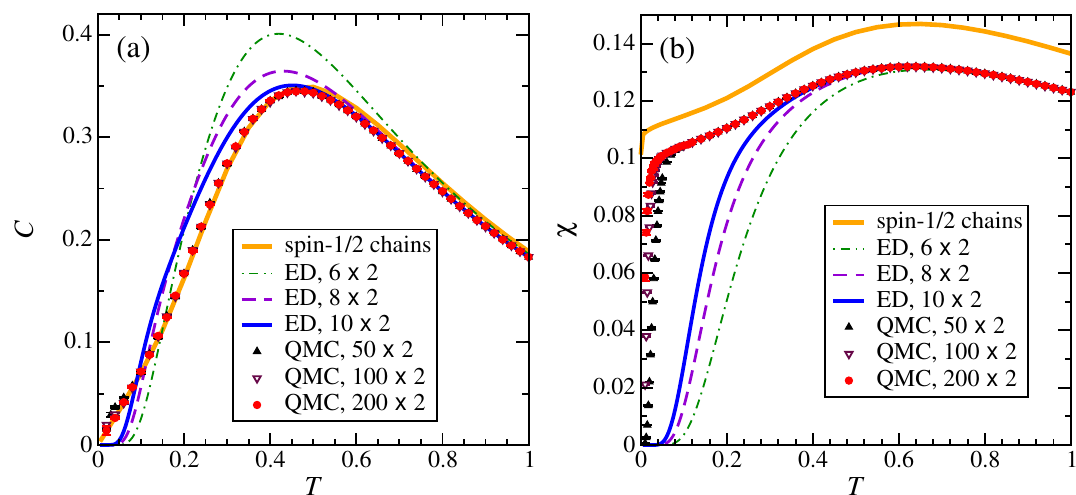
Figure 12: Magnetic specific heat, C , and susceptibility, χ , shown per spin for a ladder with rung coupling J ⊥ = 0.38, leg coupling J (cid:107) = 1, and diagonal coupling J × = 0.196. We compare QMC results obtained for ladders of L = 50, 100, and 200 rungs with ED results for L = 6, 8, and 10, as well as with exact results for two decoupled spin-1 / 2 chains, with coupling constant J (cid:107) = 1, in the thermodynamic limit [ 82 ]